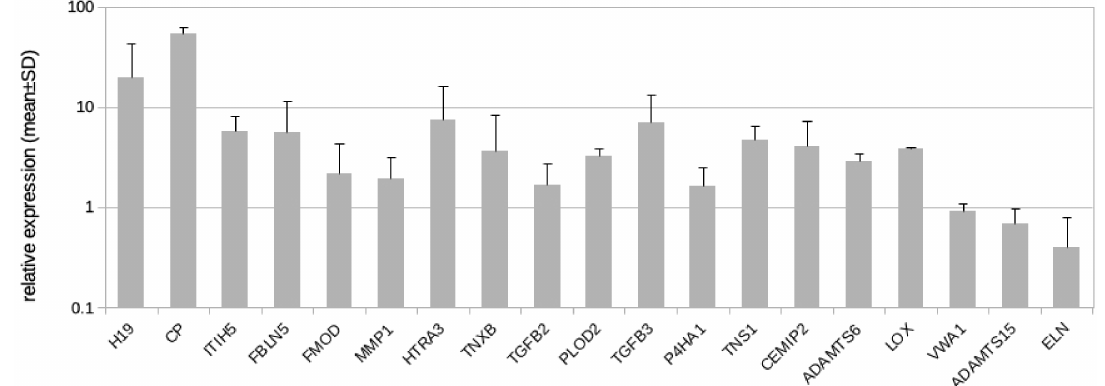
Figure 5. Real-time PCR analysis of HD-LECc5, HD-LECc6, and HD-LECc7 under hypoxia (1% O 2 ); logarithmic scale. Mean value for the normoxic condition for each gene was set to 1 to make samples comparable with the 2 − ∆∆ CT -method. Mean values from the three LEC donor samples are shown as bars; standard deviation as error bar. Primer design for CHST2 did not reveal specific probes. For H19, the design of exon-spanning primers was not possible. Calculations and plot were performed using Microsoft Excel 16 (Microsoft, Redmond, WA,